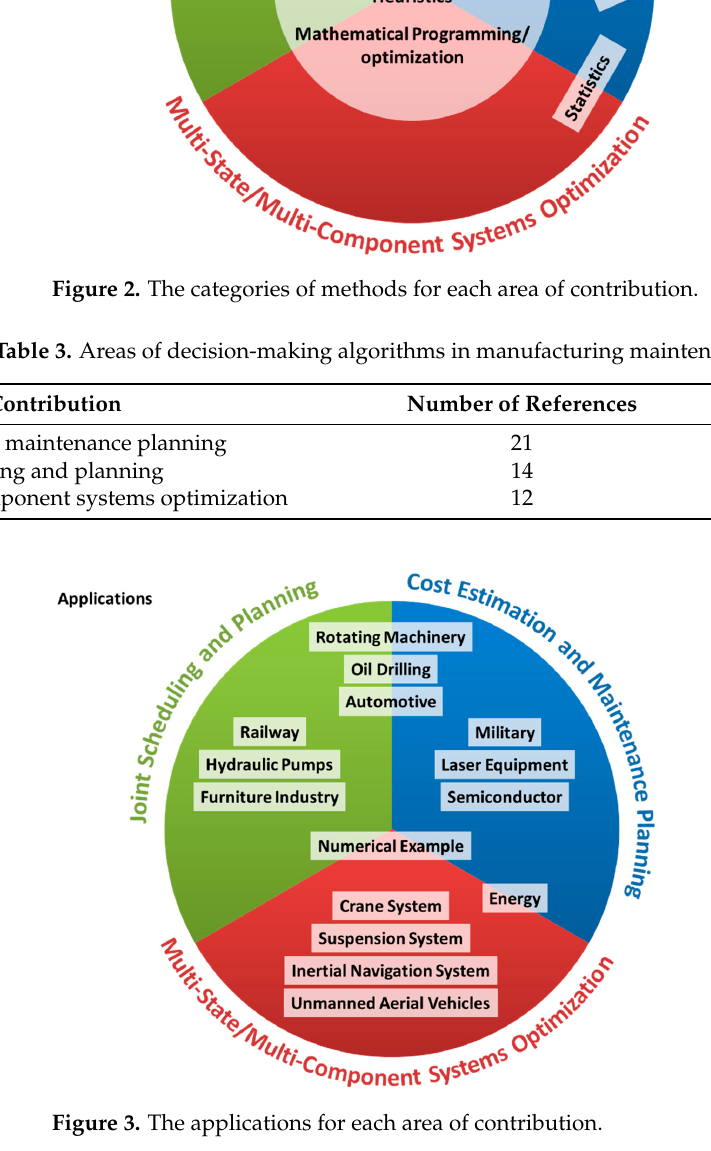
Table 3. Areas of decision-making algorithms in manufacturing maintenance.